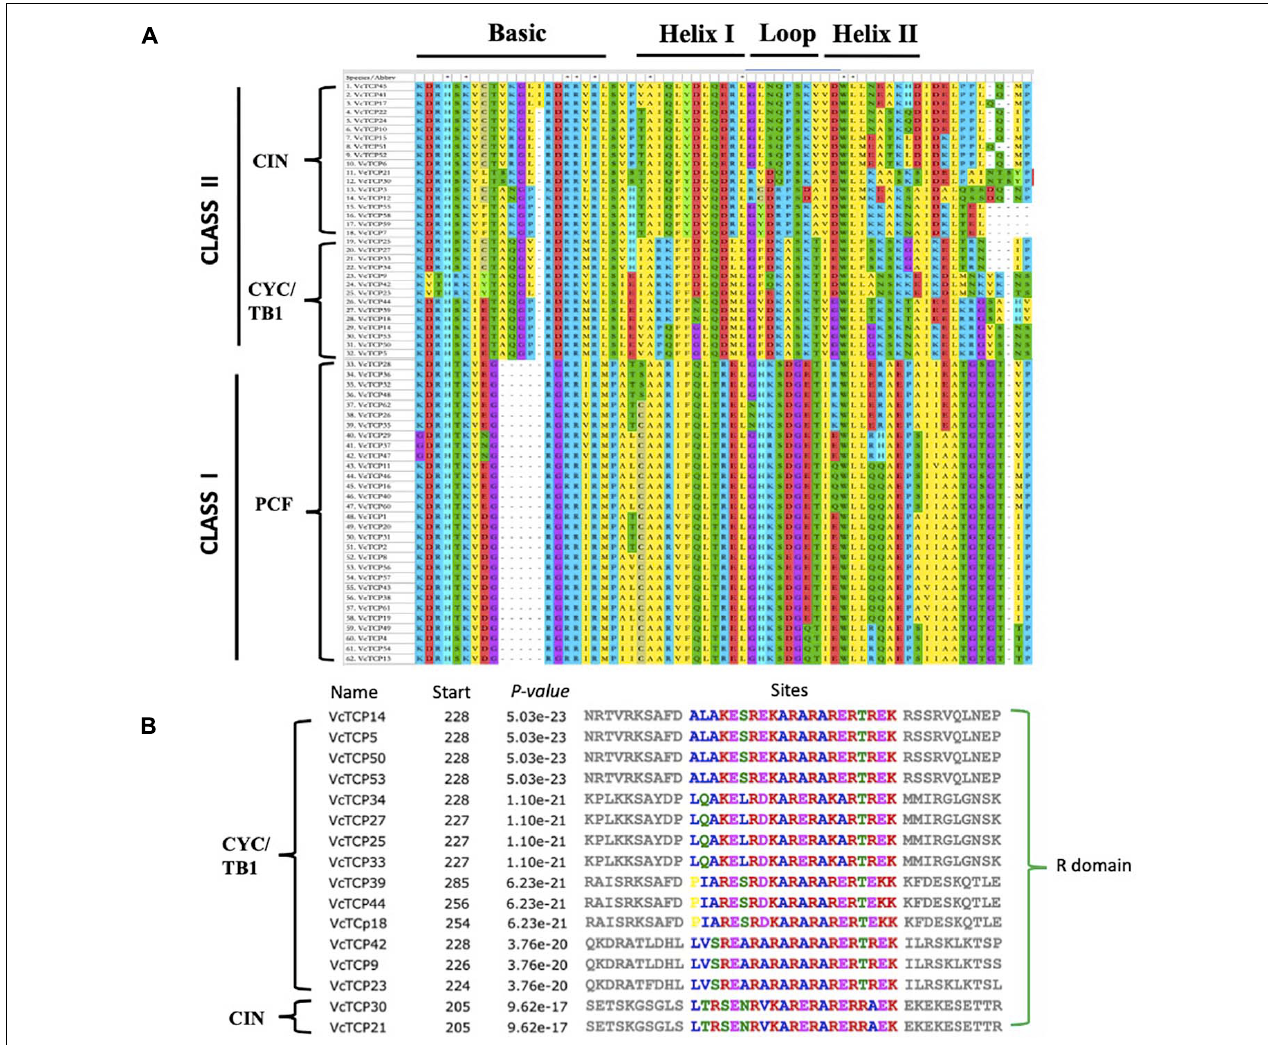
FIGURE 2 | Conserved structural domain analysis of VcTCPs in blueberry. (A) Multiple alignment of VcTCPs protein sequences was performed using MEGA X software. (B) Multiple alignment of the R domain